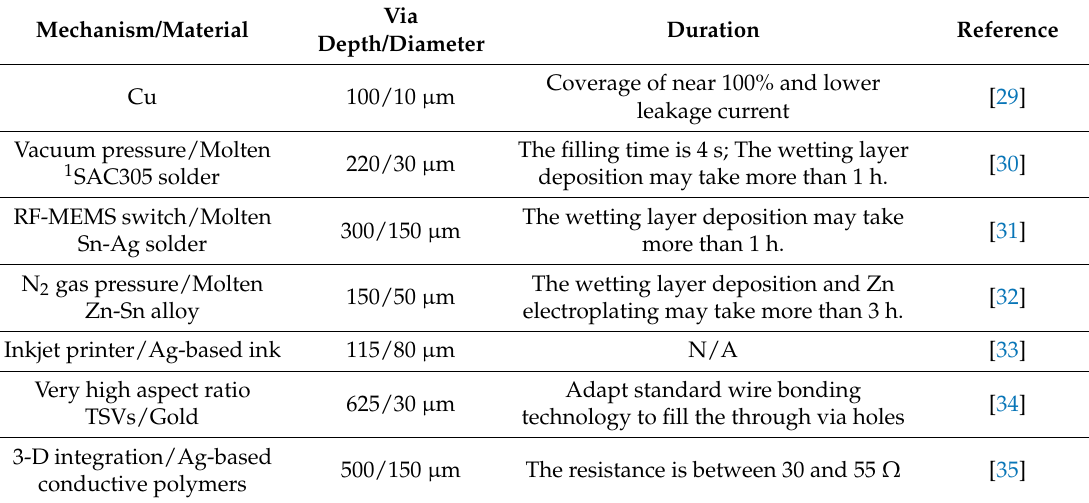
Table 2. Summary of materials to metallize